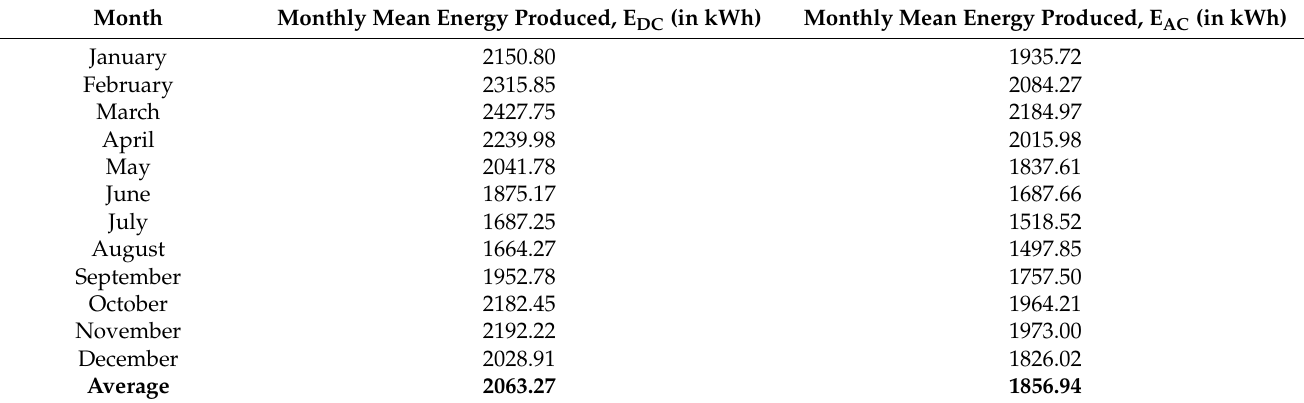
Table 6. Energy produced by SPV system at the selected site.